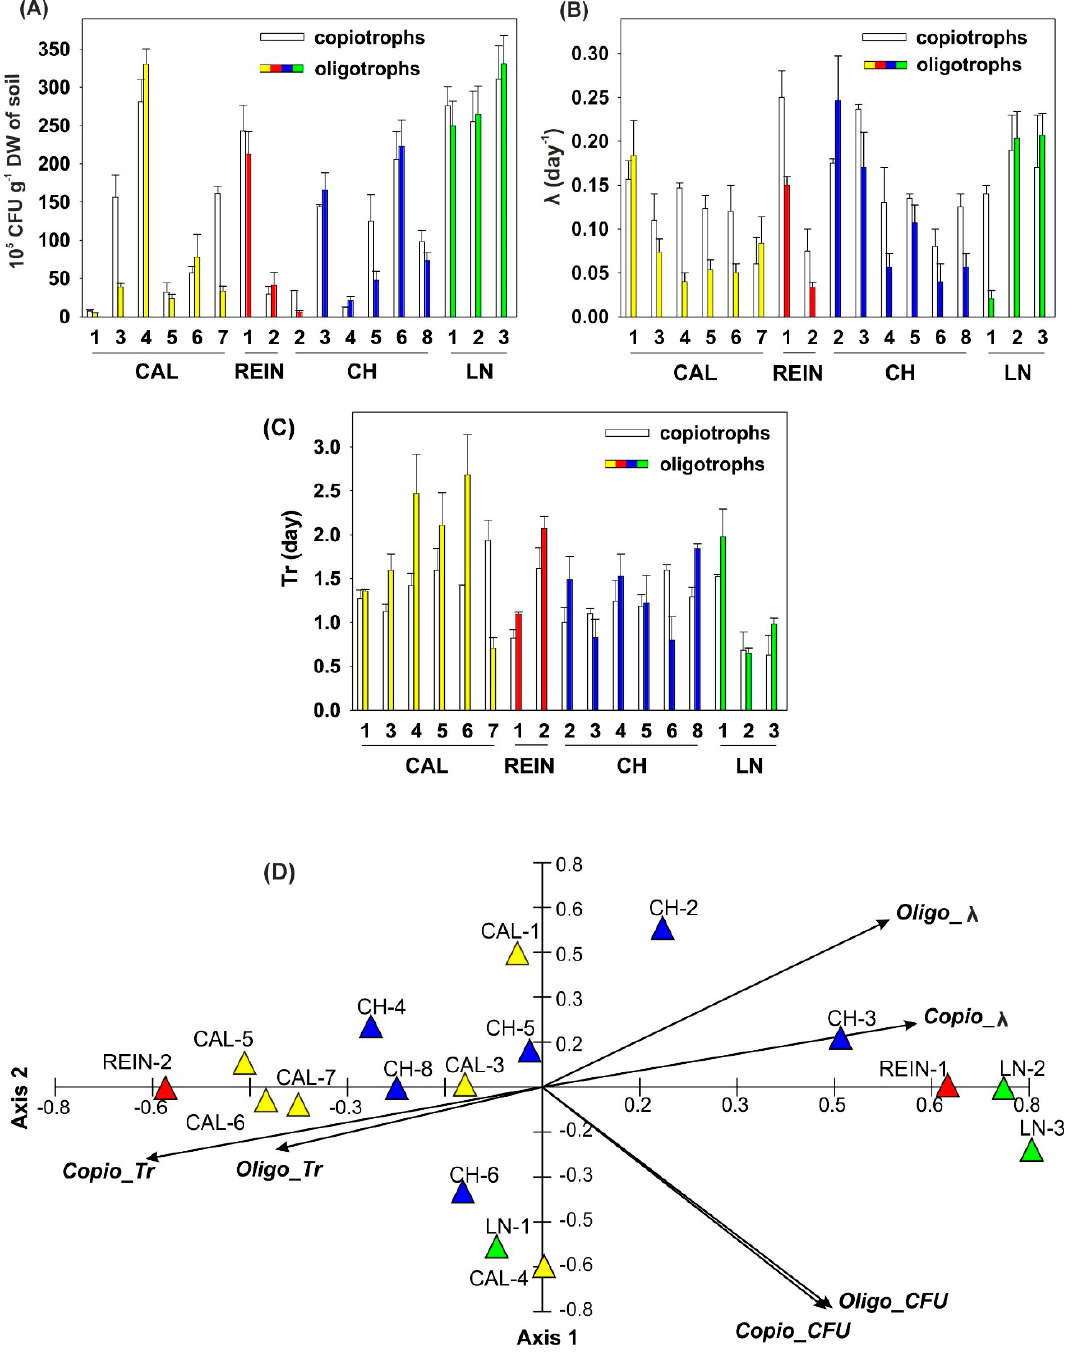
Figure 1. The colony formation by copiotrophic and oligotrophic soil bacteria based on the First Order Reaction (FOR) probabilistic model proposed by Hattori (1985), number of copiotrophic and oligotrophic bacteria; colony-forming unit (CFU) ( A ); λ = probability of visible colony formation per unit time ( B ); Tr = retardation time ( C ). The principal component analysis (PCA) for number of copiotrophic (Copio) and oligotrophic (Oligo) bacteria, and their λ and Tr ( D ).